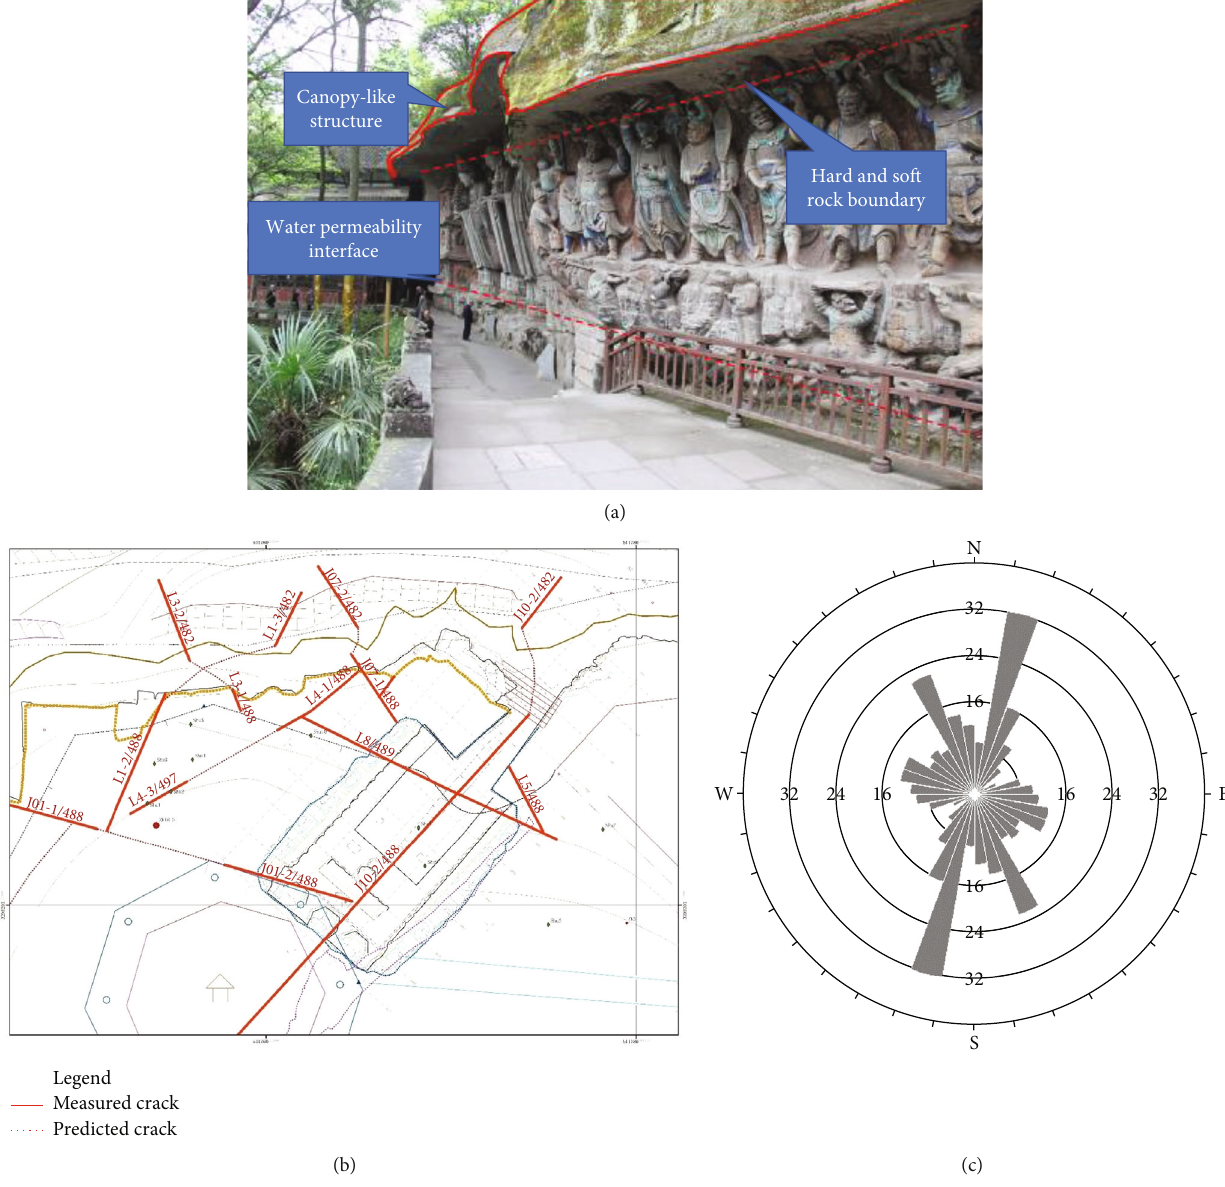
Figure 2: Characteristics of stratigraphy and fractures in the South Cli ff of Big Buddha Bay: (a) the canopy structures; (b) fracture feature; (c) joint and fi ssure strike